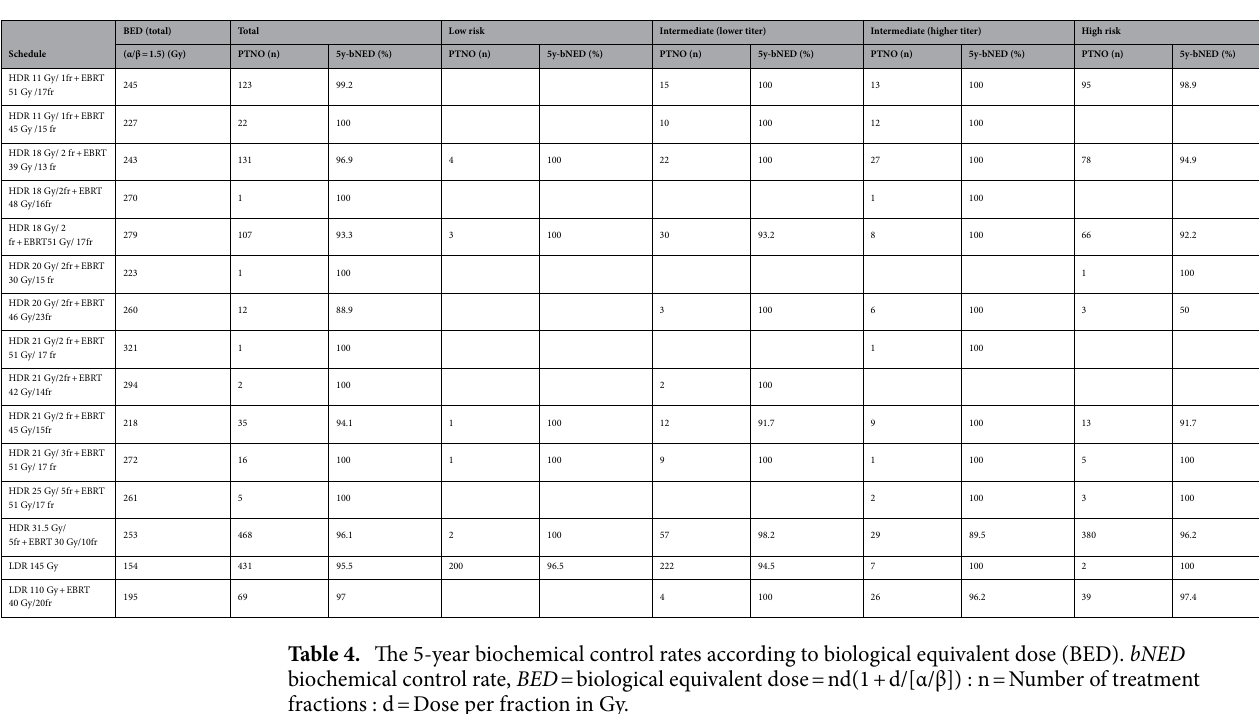
of late GI toxicities (grade ≥ 2) in the LDR-BT group (LDR-BT + EBRT vs. LDR-BT alone, hazard ratio 8.239, P = 0.0123) and HDR-BT group (LDR-BT alone vs. HDR-BT + EBRT, hazard ratio 8.701, P =